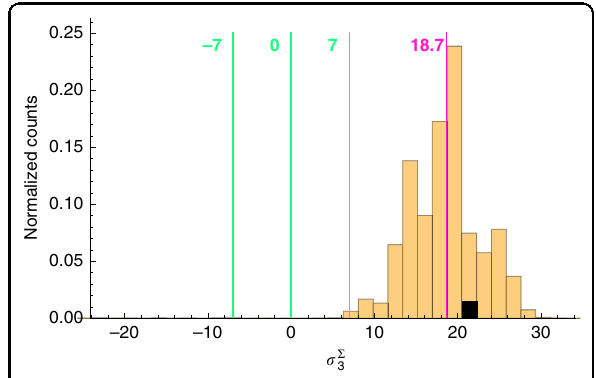
Fig. 5 Measurement of anomalous weak value. Normalized histogram of the photon counts along the x axis of the EM-CCD (see Methods) for repetitions of the single-click experiment (with unchanged parameters). The black square indicates the fi rst click of the run, corresponding to the single-click experiment. The green lines indicate the borders and centre of the eigenvalue spectrum of our observable. The purple line shows the expected (theoretical) weak value ð σ Σ 3 Þ